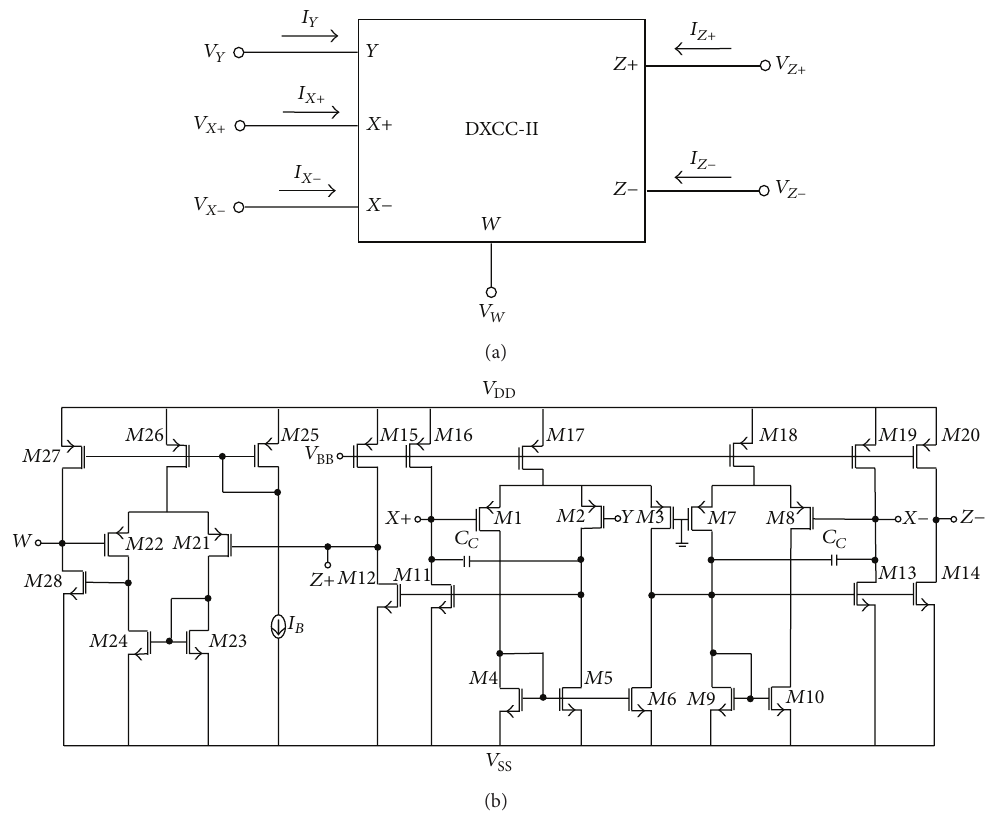
Figure 1: (a) Symbol of DXCC-II with buffer, (b) CMOS implementation of DXCC-II with buffer [5].